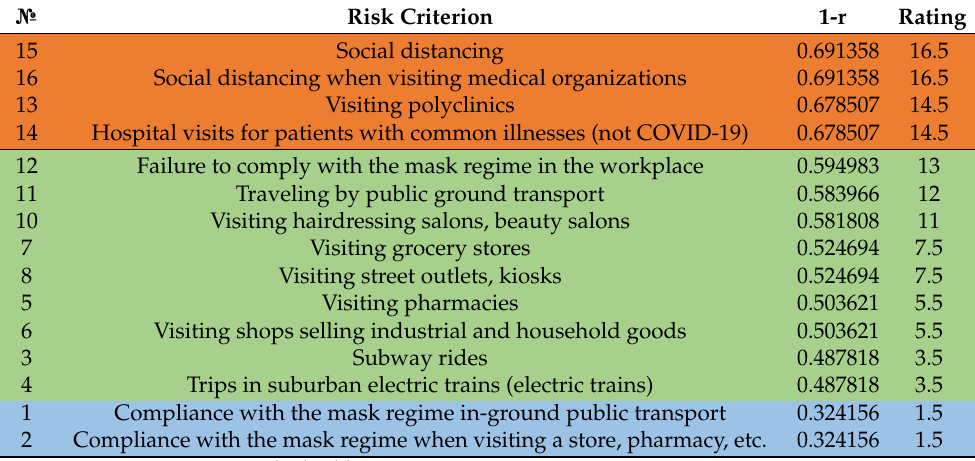
Table 1. Hierarchy of informative features (risk